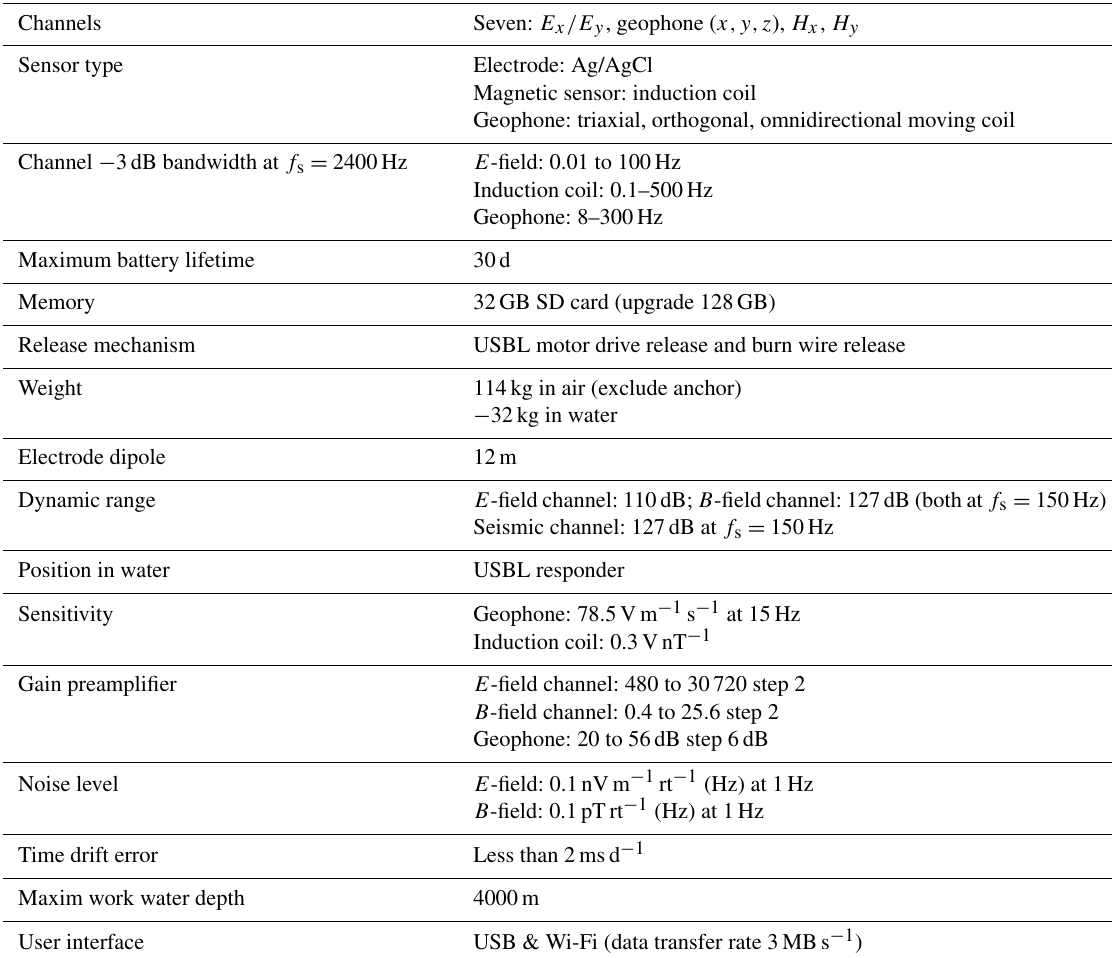
Table 1. Technical specifications for the ocean bottom electromagnetic receiver and seismometer (OBEMS).